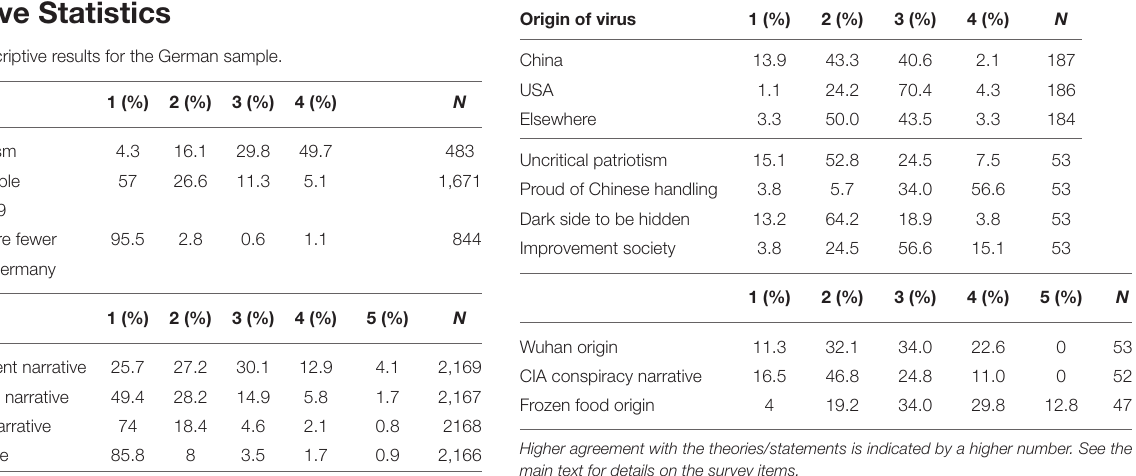
TABLE A2 | Descriptive results in